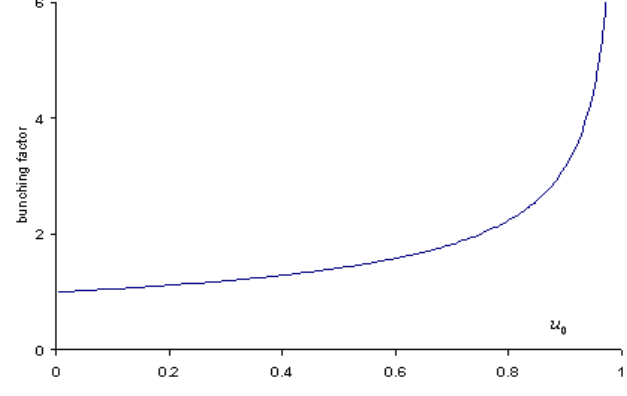
(cid:3) V =V . 0 0 synch